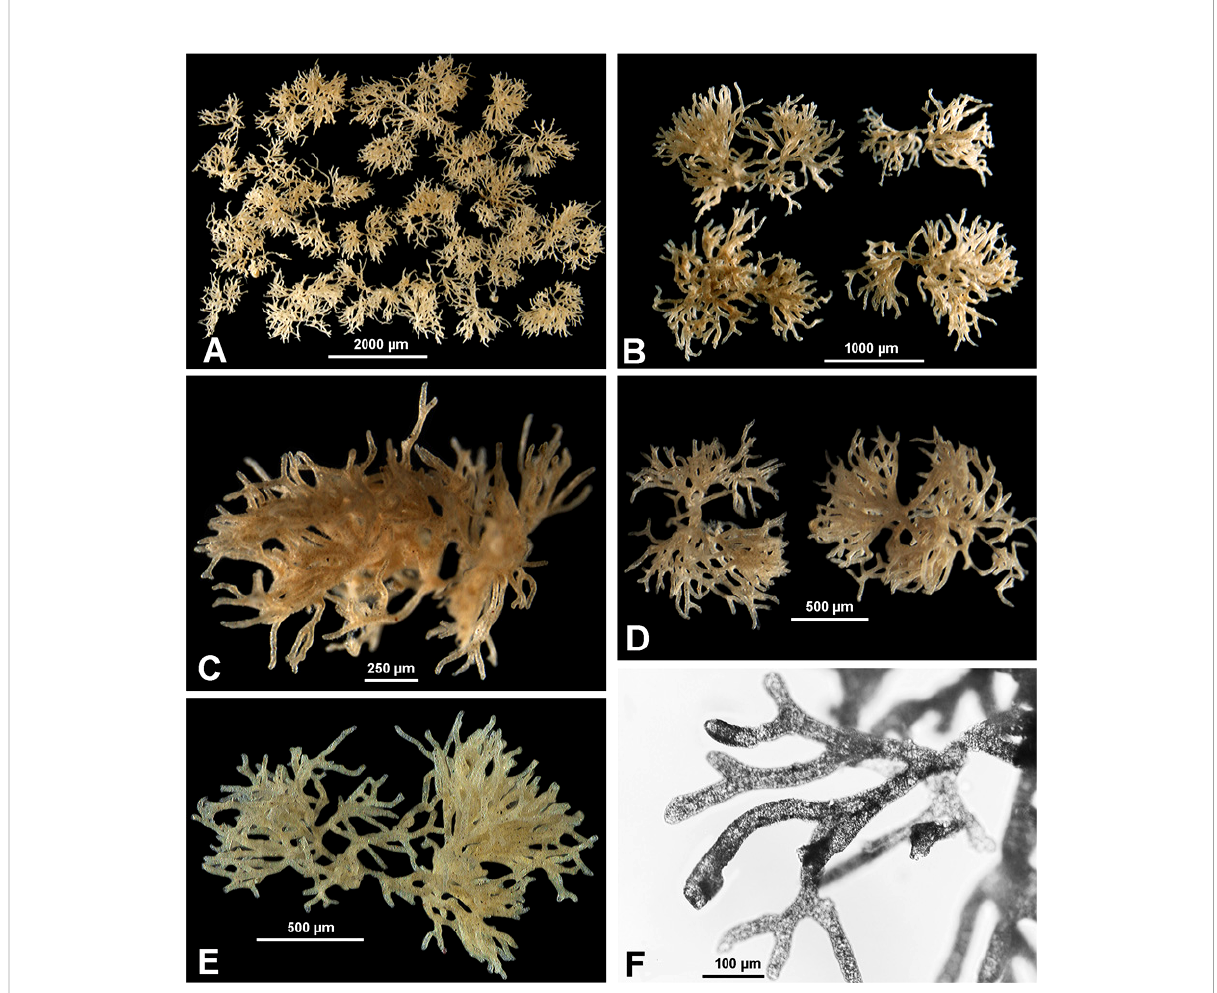
FIGURE 4 Komokia -like komoki from APEI-3. (A) Sample 210. ( B Sample, D – F ) Sample 192. (C) Sample